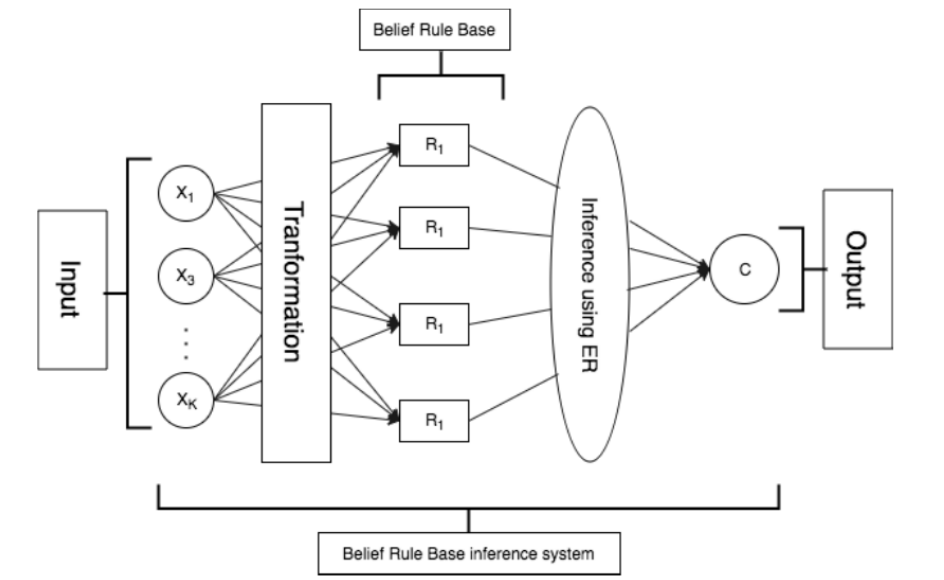
Figure 4. Working procedure of BRBES.